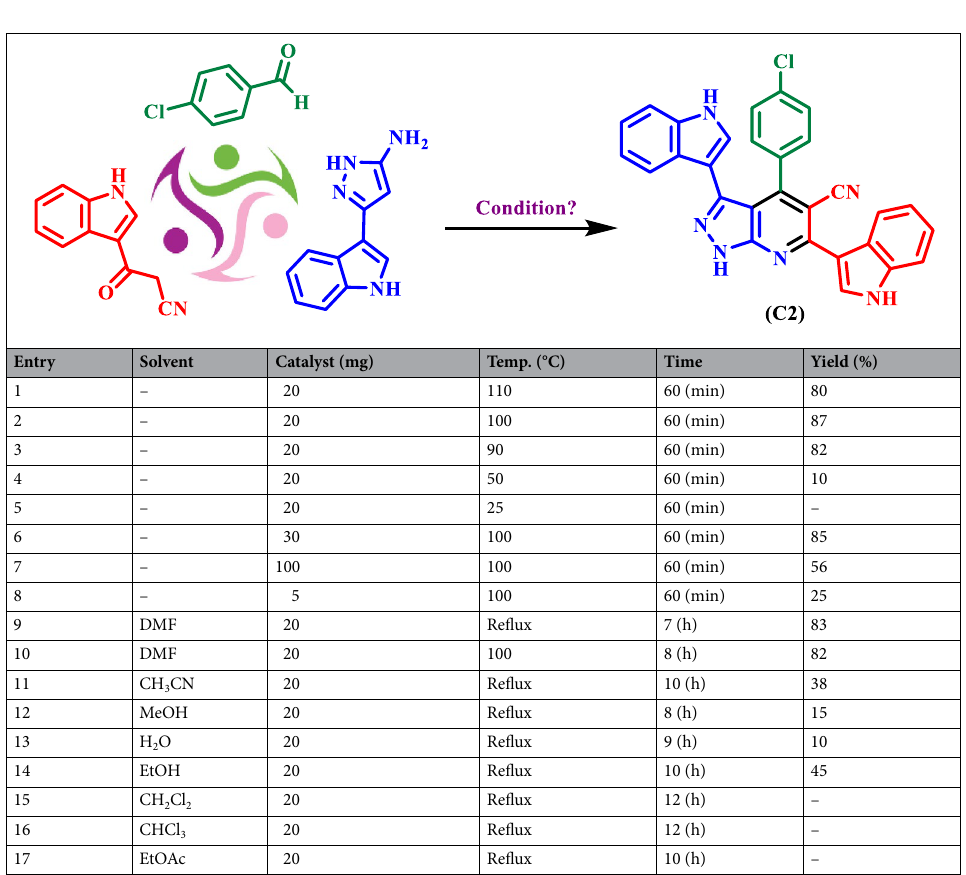
Table 2. Optimization parameter on the synthesis C2